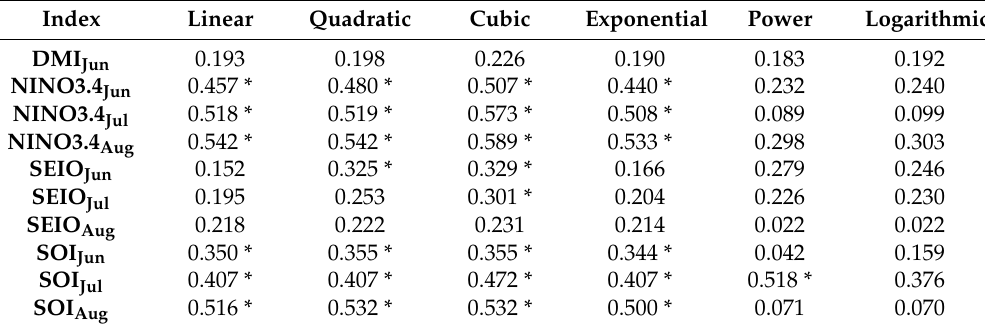
Table 2. Pearson correlations of the regression analysis for Tharwa General Store station.